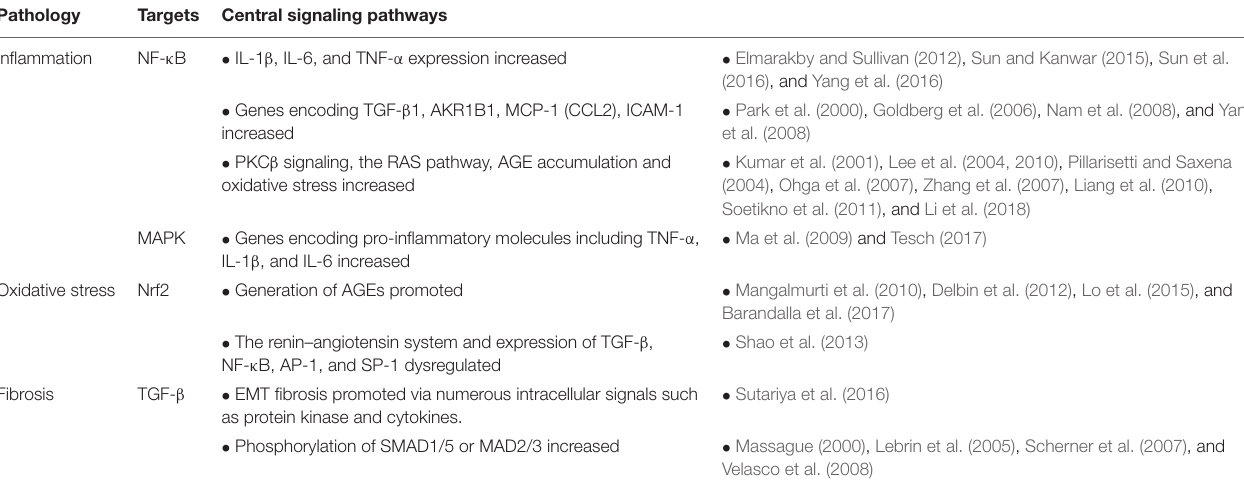
TABLE 1 | The roles of central signaling pathways in the common abnormal cellular activities in DN.